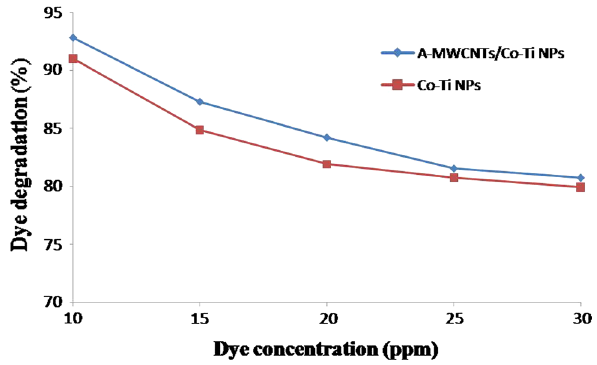
Fig. 11 Comparison of %degradation of RB dye at different initial dye concentrations at constant amount of A-MWCNTs/Co–Ti oxides and Co–Ti oxide NPs